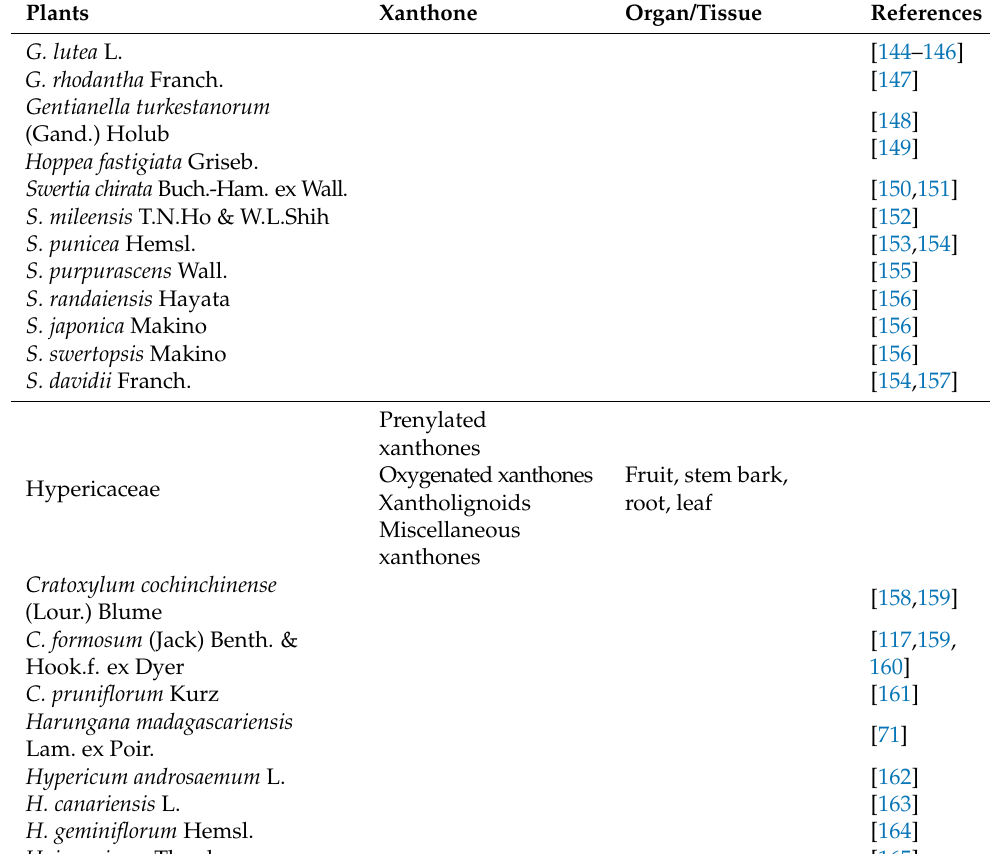
(Gand.) Holub Hoppea fastigiata Griseb. Swertia chirata Buch.-Ham. ex